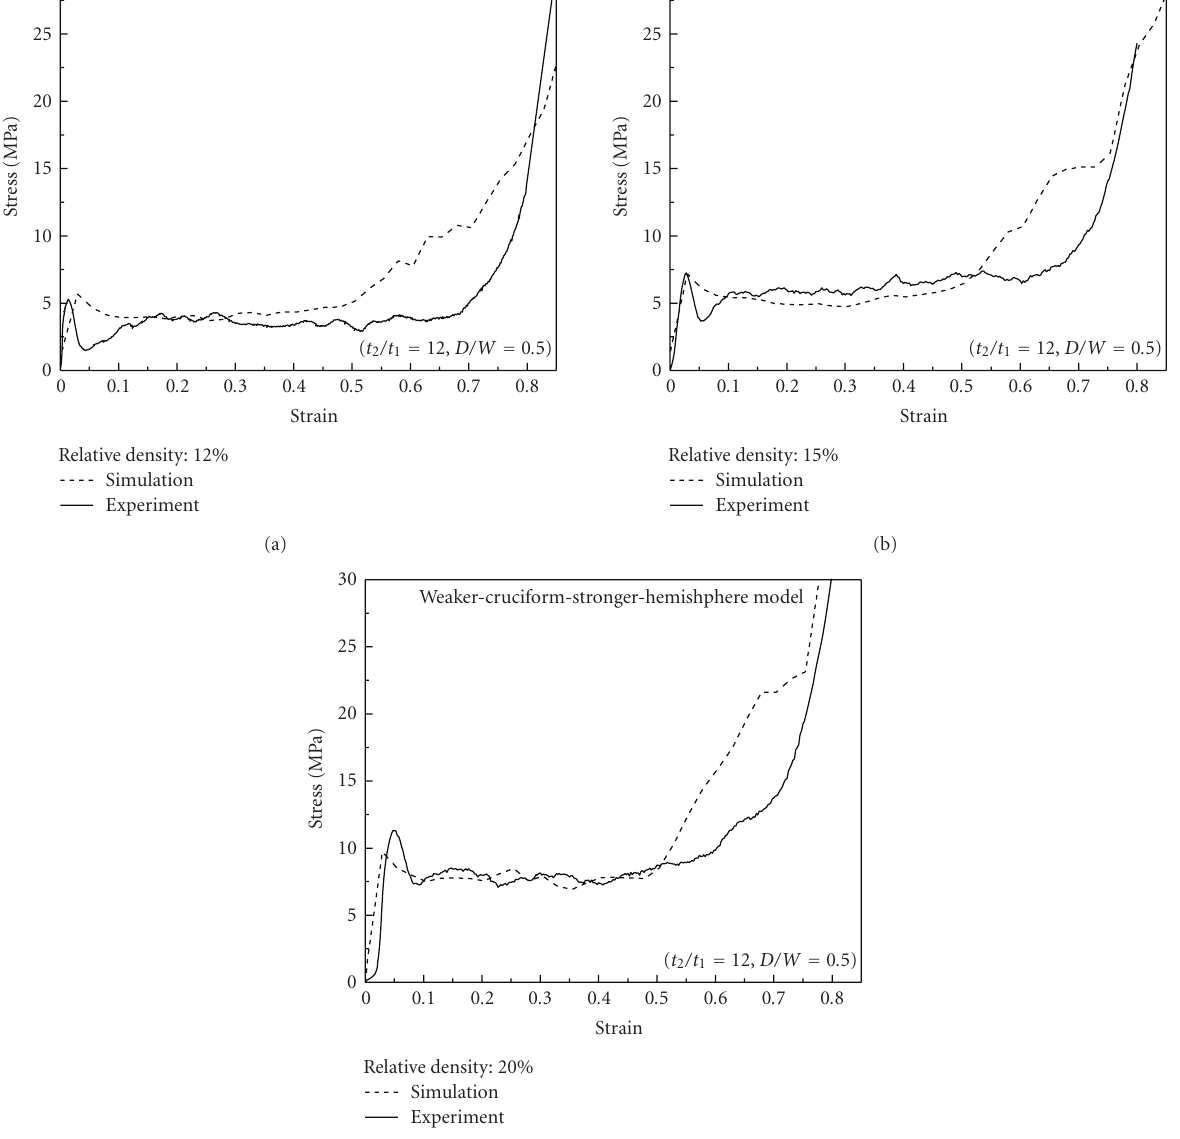
0.3003 mm and 0.5006 mm respectively. A numerical